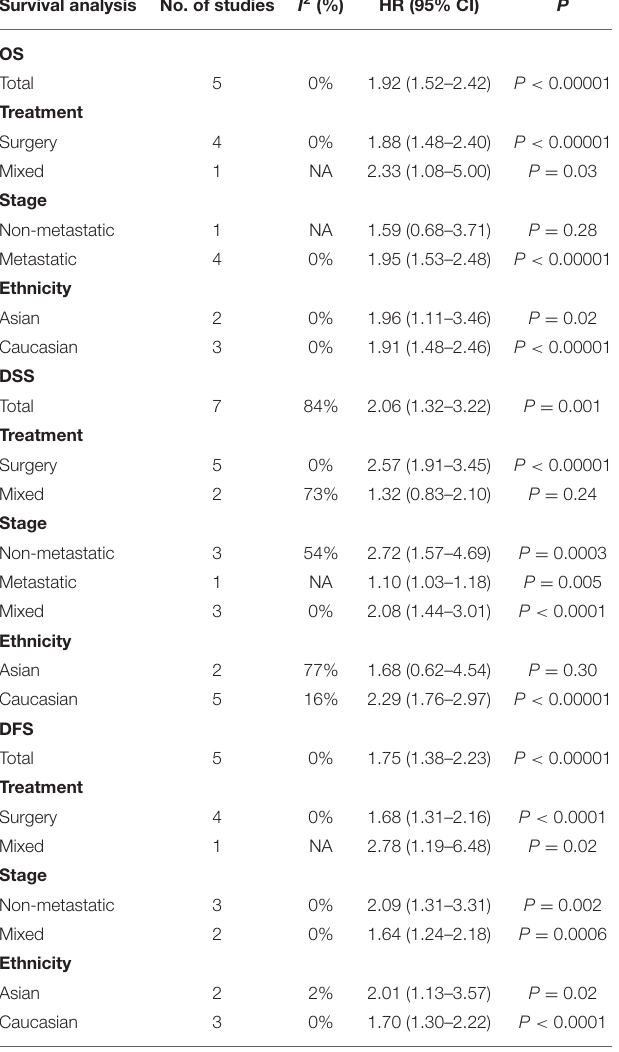
TABLE 4 | Subgroup analysis of the prognostic value of PLR. Survival analysis No. of studies I 2